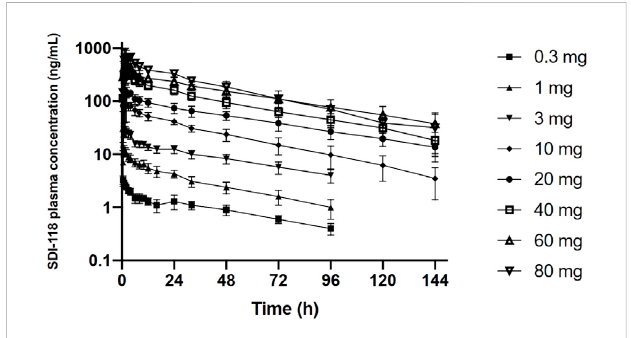
FIGURE 1 Graphic representation of the(log) plasmaconcentration over time pro fi le of the single ascending dose part of the study. The graph demonstrates dose proportionality over the entire dose range.